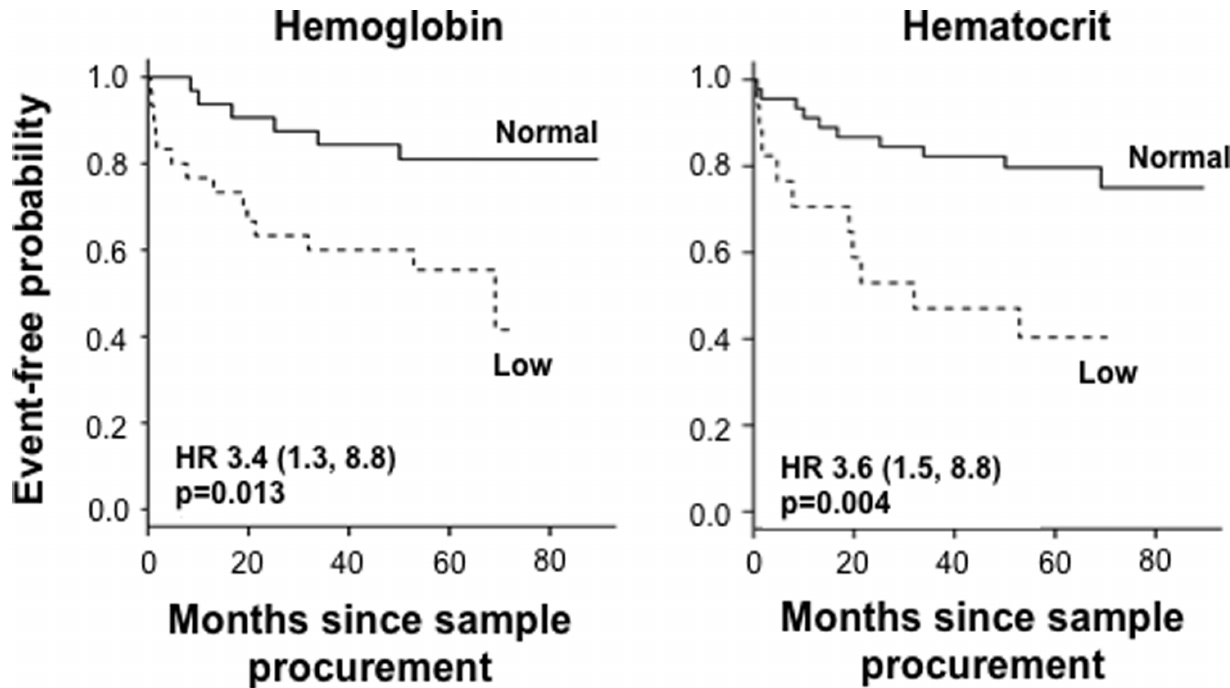
Figure 1. Hemoglobin (Hgb) and hematocrit (Hct) in the prediction of complicated Crohn’s disease - Kaplan-Meier survival analysis for event-free probability. The broken line represents the population with low Hgb ( , 14.2 g/dl for males and , 13.3 g/dl for females) or low Hct ( , 40% for males and , 37% for females), respectively. The full line represent the population with normal Hgb or Hct. P-values and Hazard ratios (HR) as indicated in the figure.